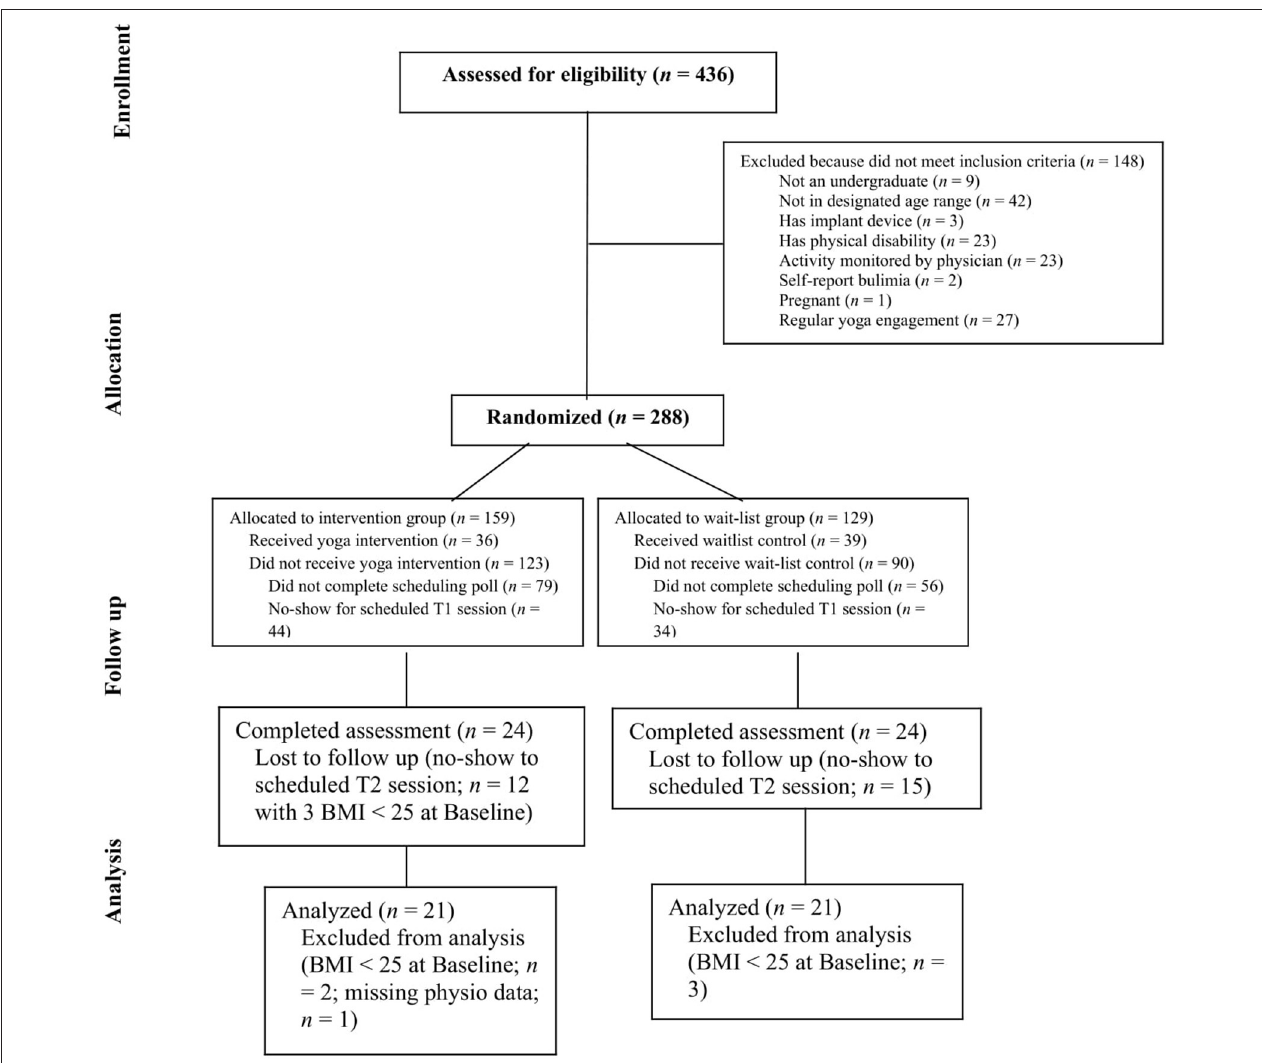
FIGURE 1 | CONSORT flow